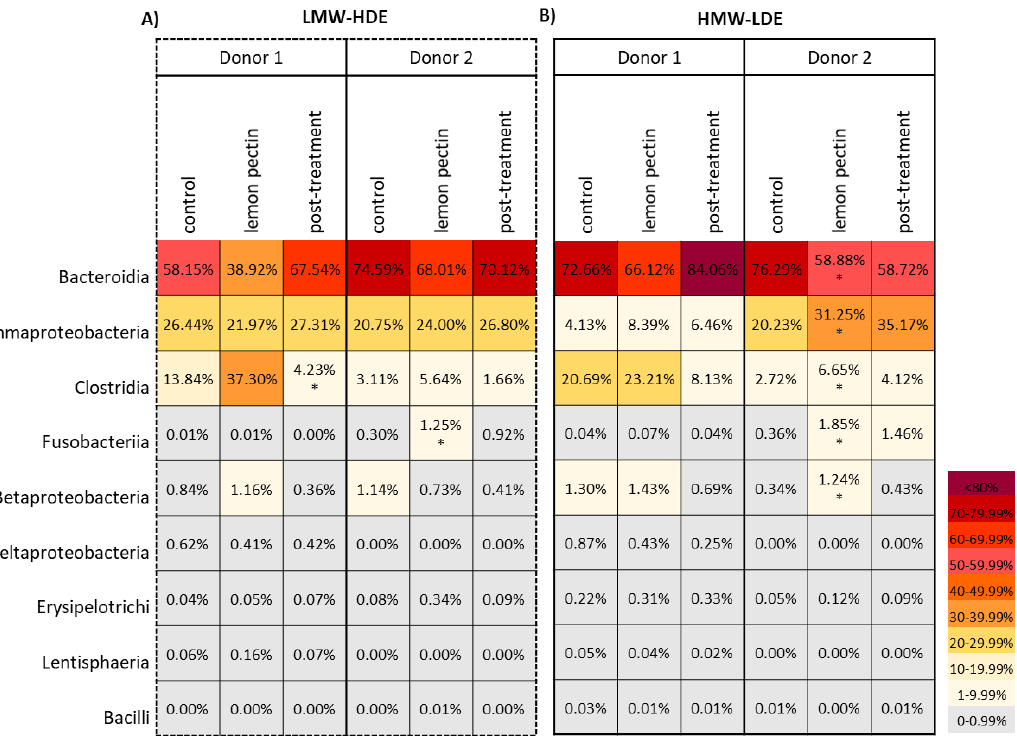
Figure 3. Heatmap depicting relative abundance at the class level for taxa present at >0.01% percent abundance in at least one sample. Significant changes are indicated in the figure with an asterisk (*) symbol. ( A ) LMW-HDE pectin. ( B ) HMW-LDE